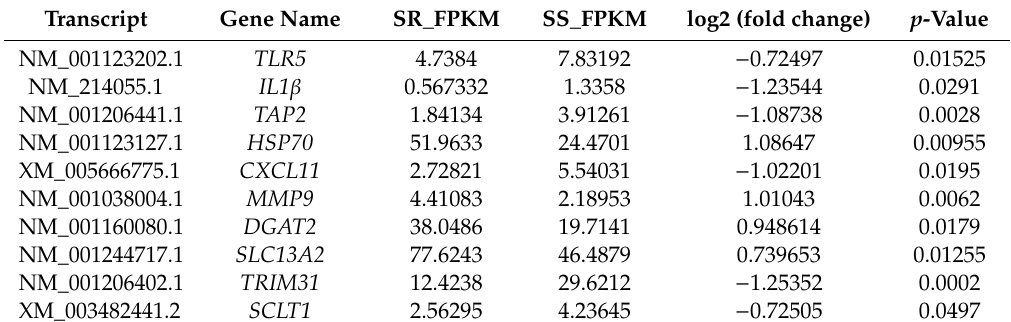
Table 1. Partial list of di ff erentially expressed genes in Sutai weaning piglets resistant and sensitive to E. coli F18